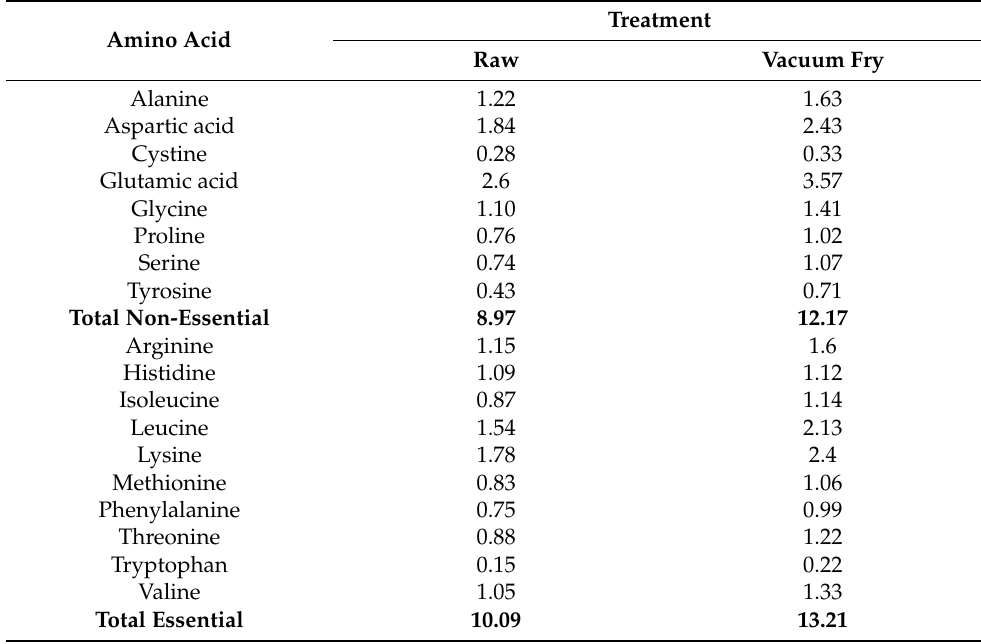
Table 4. Amino acid profile (g/100 g) of chub mackerel ( Scomber japonicus ) after vacuum